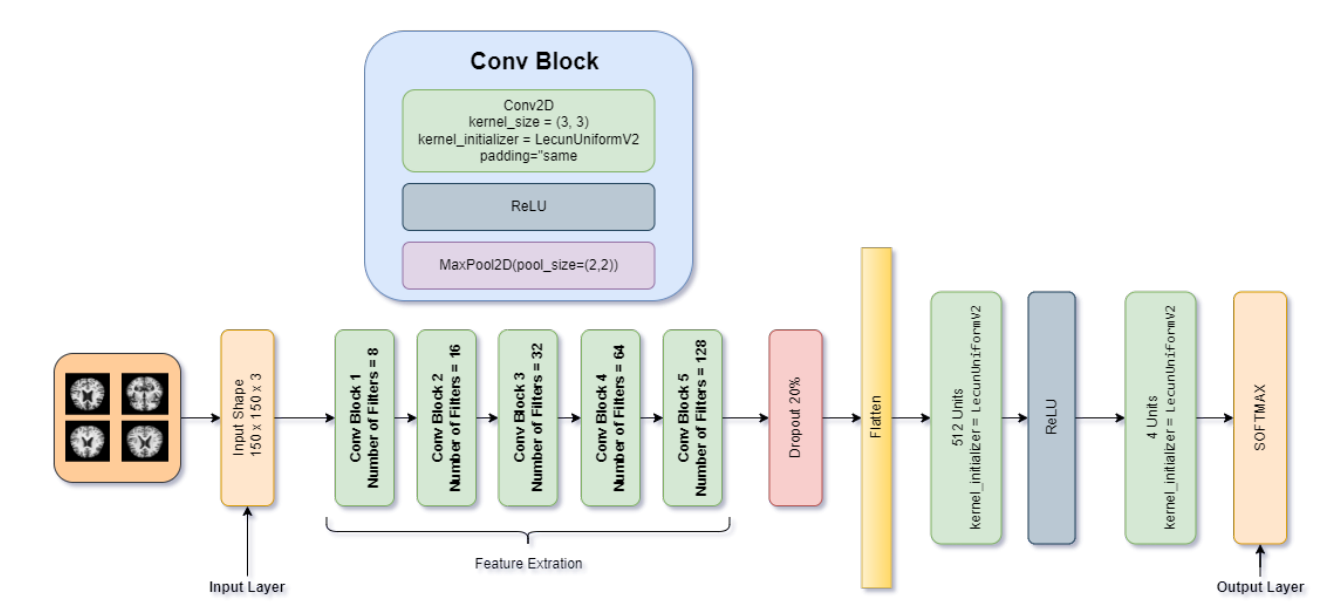
Figure 6. Detailed architecture of the proposed DAD-Net for early detection of